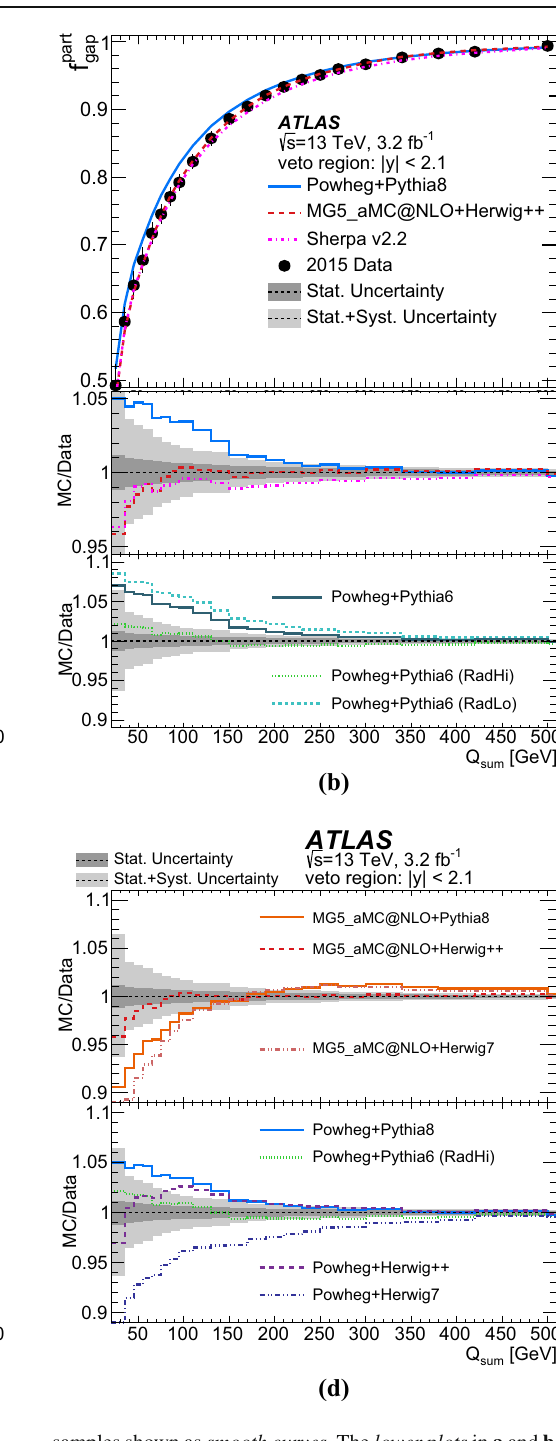
samples shown as smooth curves . The lower plots in a and b and the set of ratio plots in c and d show the ratio of predictions to data, with the data uncertainty indicated by the shaded band , and the Q sum thresholds corresponding to the left edges of the histogram bins , except for the first